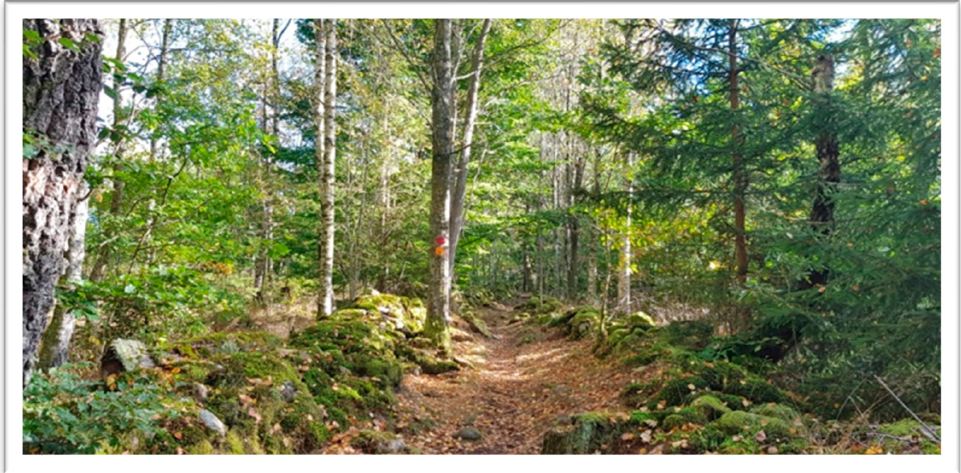
Figure 5. Mixed forest in Fulltofta and the forest walking path. [Photo: Marianne Larsson].